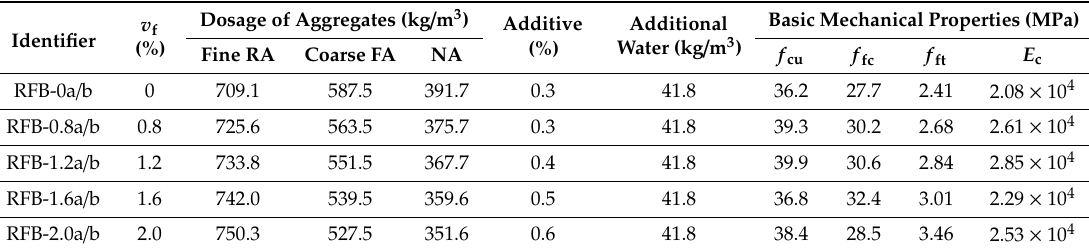
Table 2. Mix proportion and basic mechanical properties of steel fiber reinforced composite-recycled aggregate concrete (SFR-CRAC) for test